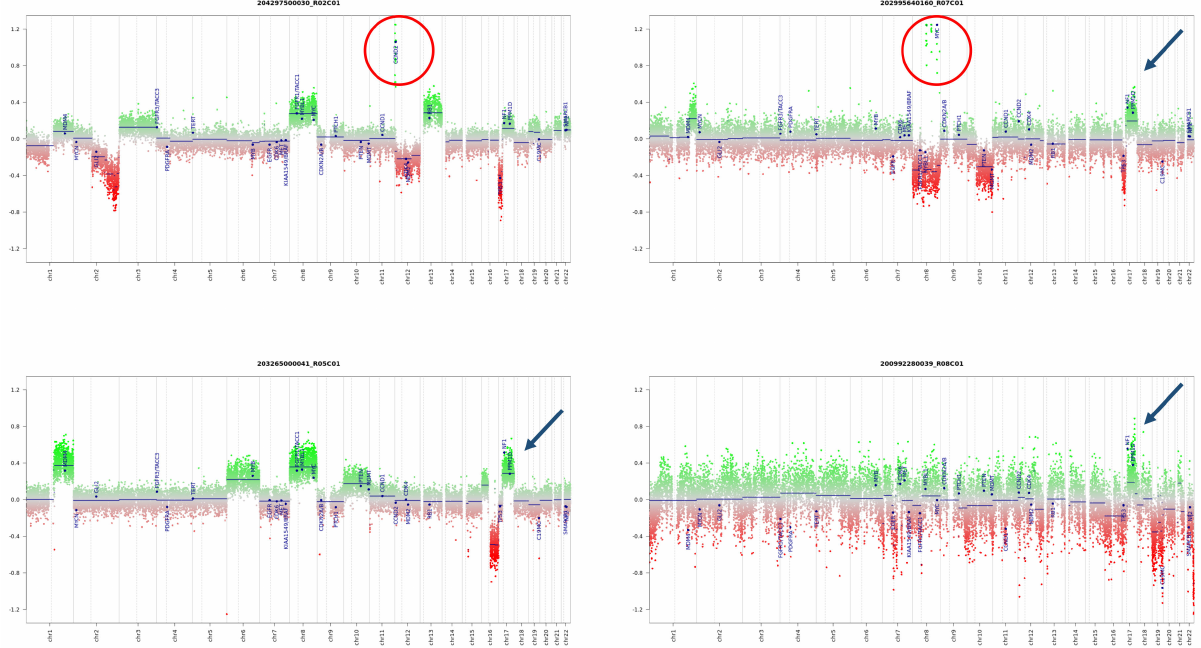
Figure 7. CNV of four different MBG3, subtype II analyzed at Ospedale Pediatrico Bambino Ges ù . The CNV analysis shows recurrent gene and chromosomal alterations (e.g., MYC amplification [red circles] and Chr 17q gain (blue